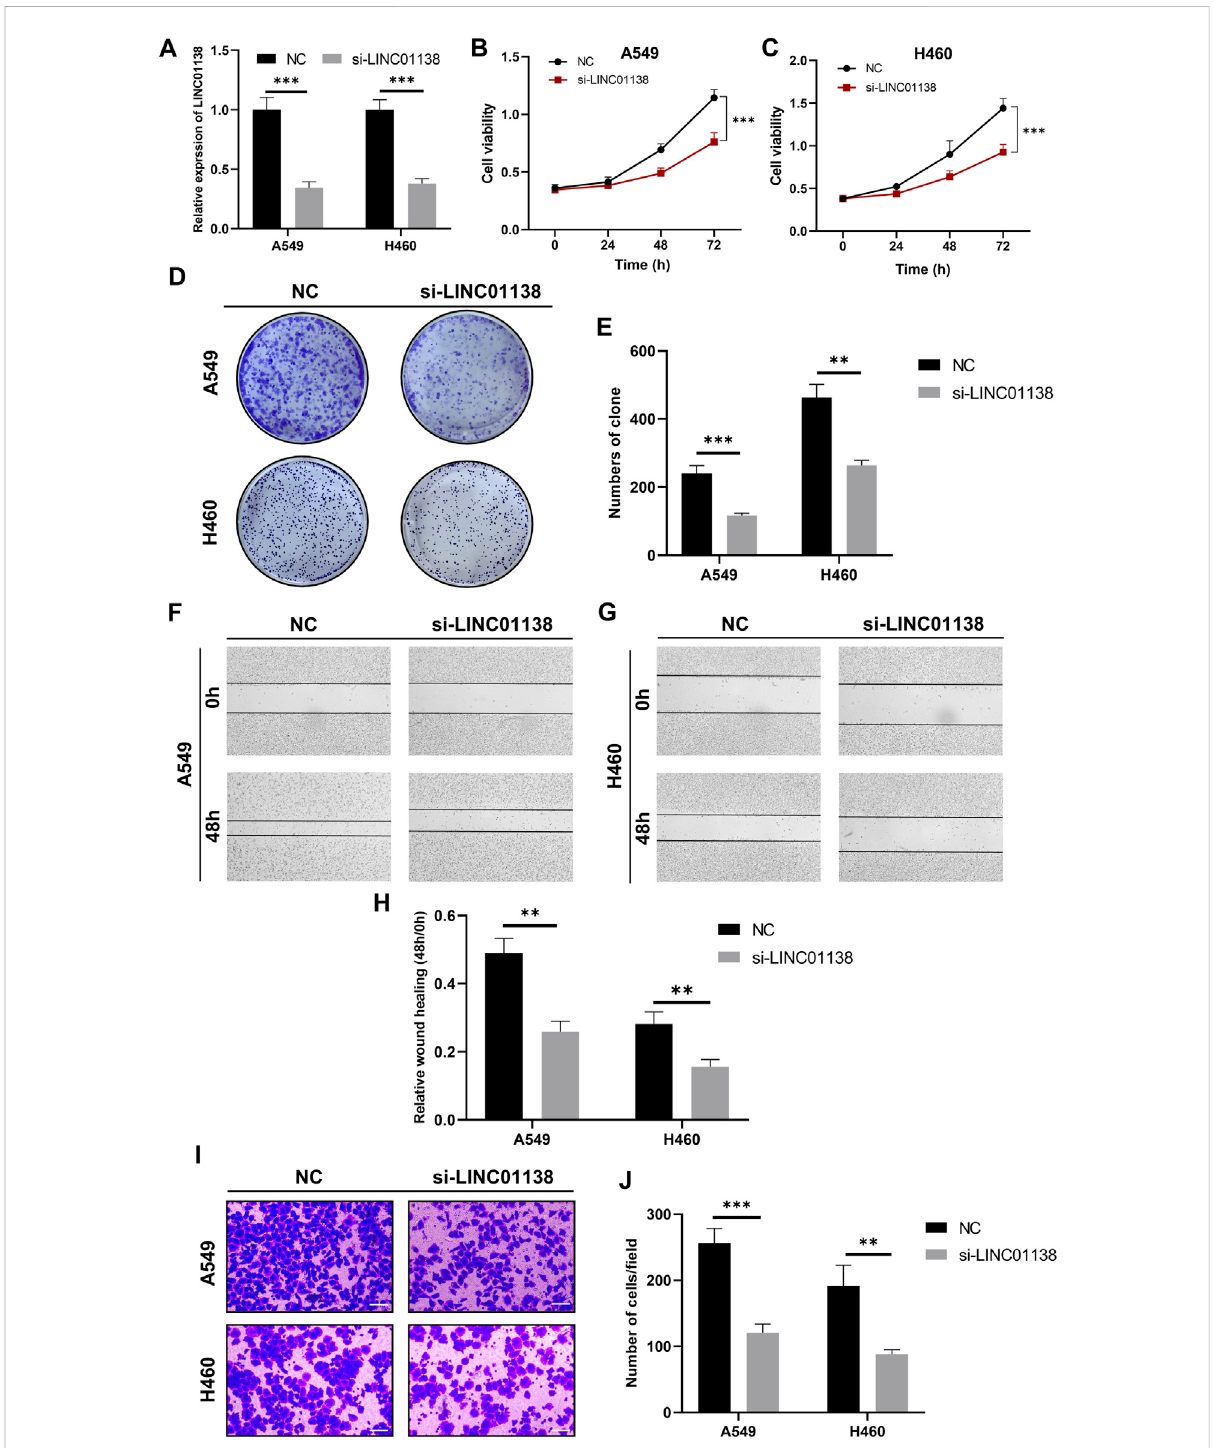
FIGURE 10 Knockdown of LINC01138 repressed viability, proliferation, and migration of A549 and H460 cells. (A) Expression of LINC01138 in A549 and H460 cells after its knockdown. (B,C) CCK-8 assay results showing viability of A549 and H460 cells after LINC01138 knockdown. (D,E) The proliferation of A549 and H460 cells evaluated using colony formation assay. (F – H) Migration capacity of A549 and H460 cells tested using wound- healing assay. (I,J) Migration capacity of A549 and H460 cells tested using Transwell assay. The scale bars represent 200 μ